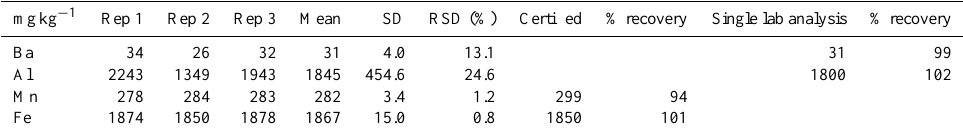
Table A1. Percentage recoveries of BCR-414 certified reference material. Certified and single lab values taken from the final report of the Commission of the European Communities, Community Bureau of Reference for BCR-414,